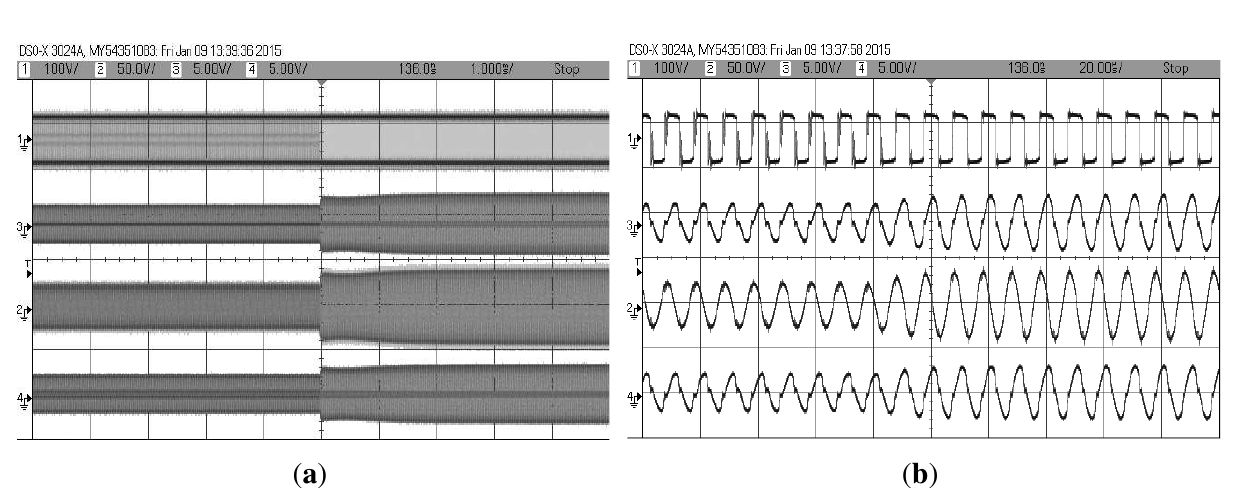
(5 A/div), v (50 V/div), i (5 A/div) s Cs t